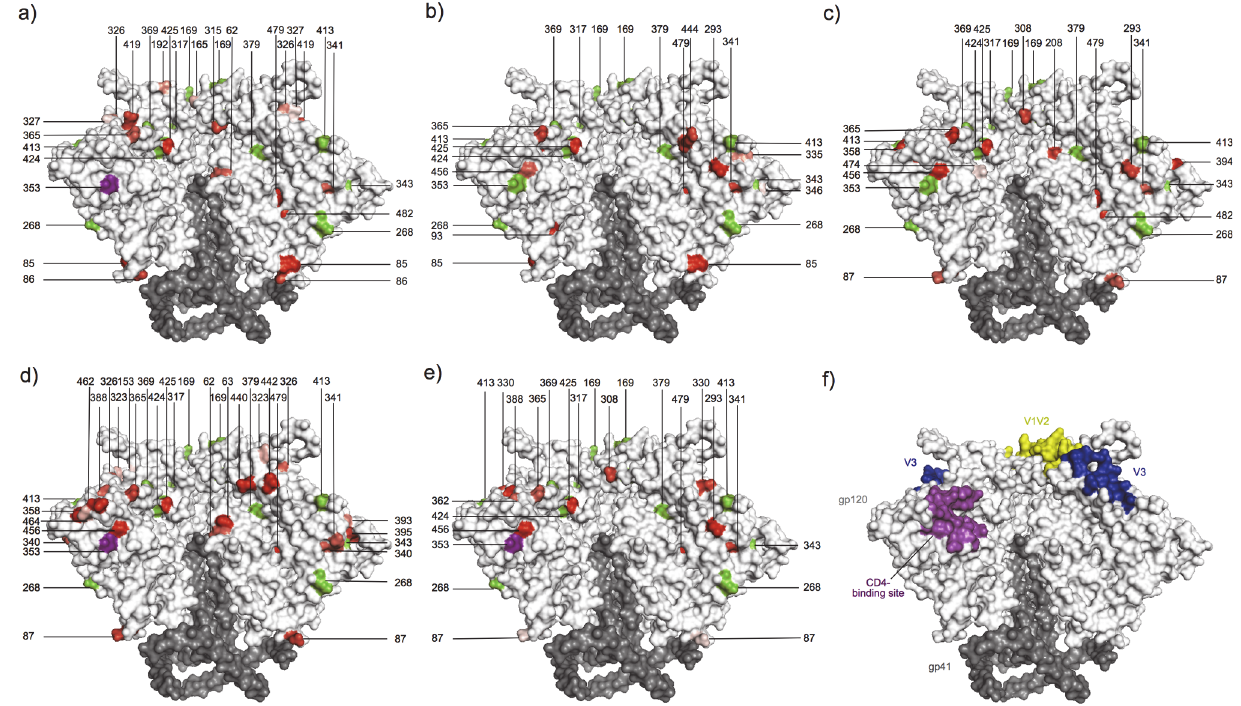
Figure 7. Mapping of signature sites and sites under selection on an Env trimer structure. Trimer (PDB id: 4NCO [27]) is shown in surface representation, with gp120 in grey and gp41 in dark grey. (a-e) Panels correspond to the five physico-chemical properties analyzed for evidence for property importance: (a) chemical composition, (b) polarity, (c) volume, (d) isoelectric point or (e) hydropathy [25]. Signature sites identified in Env-gp120 are colored in green, and sites that were under selection are colored from pink to red (corresponding p-values from 0.05 to < 0.0001). (f) Visualization of the major sites of vulnerability on the HIV-1 Env.